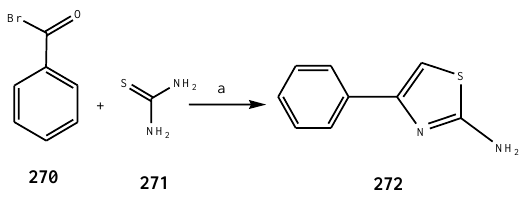
Scheme 19. Total synthesis of 4-thiazolylpyrazoles.